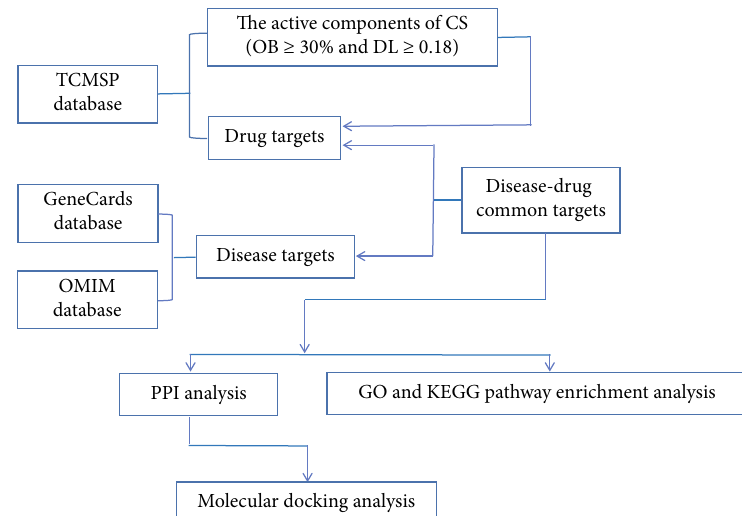
Figure 1: A work fl ow presenting the study design.